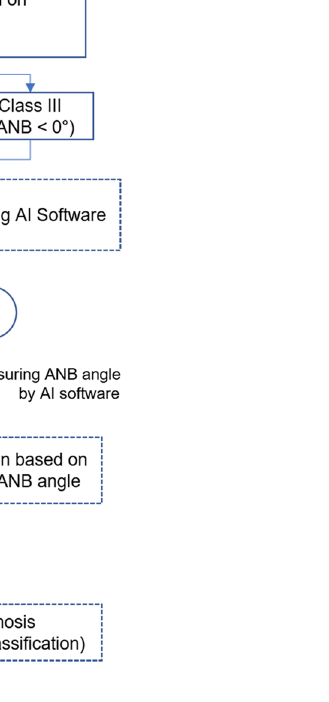
Figure 1. The flowchart of this